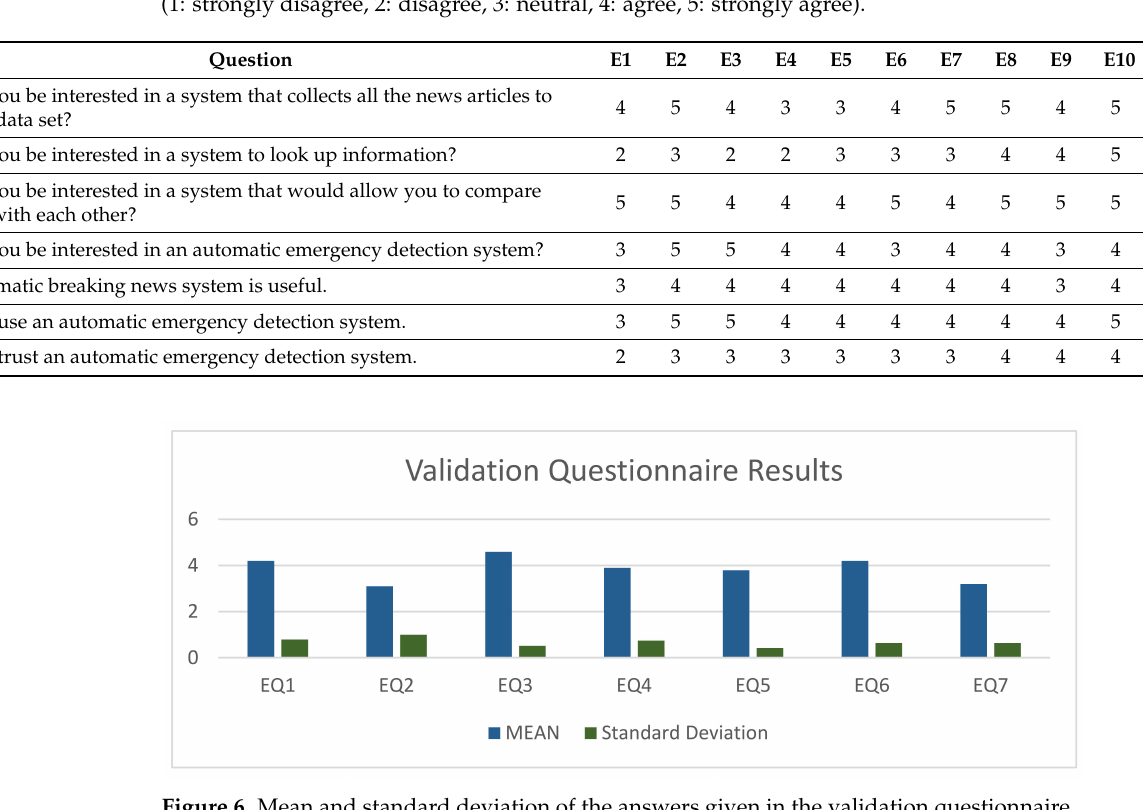
Table 3. Questionnaire answered, evaluating the acceptance of presented work by experts (E1–E10)